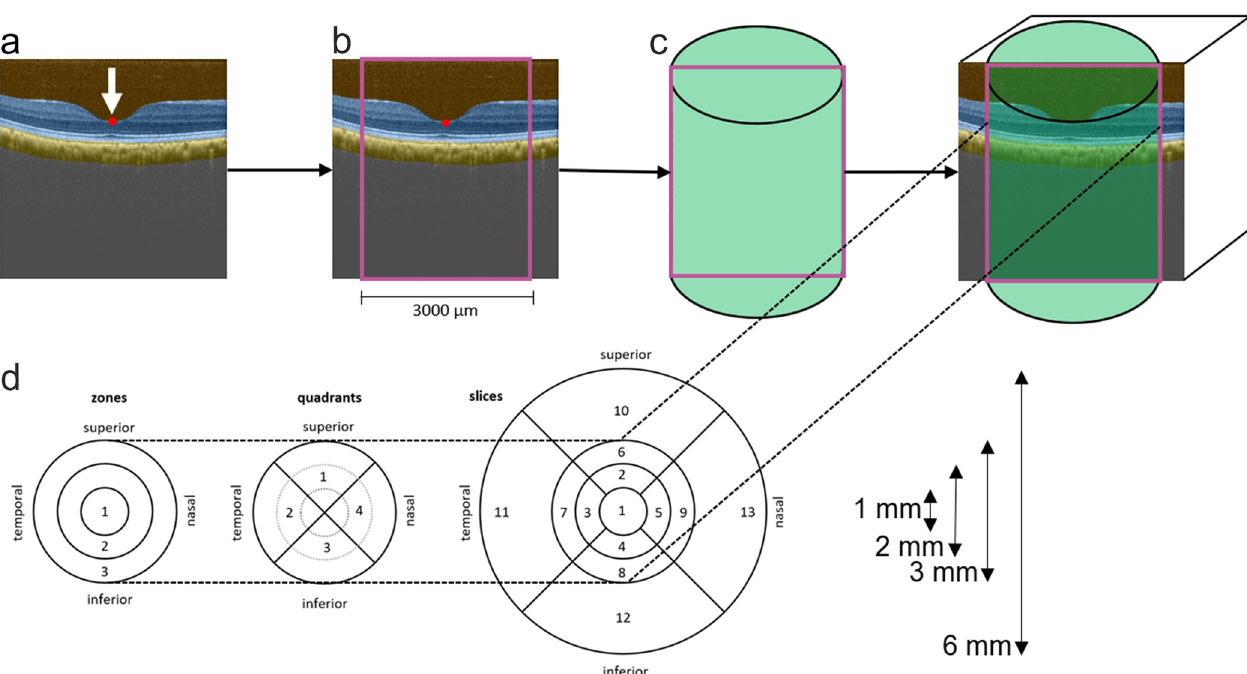
Fig 1. Choroidal volume measurements in a right eye. a. A machine learning algorithm was trained to detect the choroid from an obtained macula volume OCT scan (highlighted in yellow; brown = vitreous, blue = retina). For a better overview, only a single B-scan is illustrated here. Consequently, a classic algorithm automatically defined the deepest location within the foveolar depression which was marked a nulla (arrow, red spot). b. Starting from nulla, a rectangle (depicted in pink) was defined to the side with a total length of 3000 μ m. c. This rectangle was rotated axially centered on nulla to segment the choroid within the OCT volume allowing measurements only the central and paracentral subfields. d. From the segmented choroid volume, choroidal sub- fields were analyzed, marked as circular zones, quadrants, and slices. (outer zones 10–13 were not investigated).